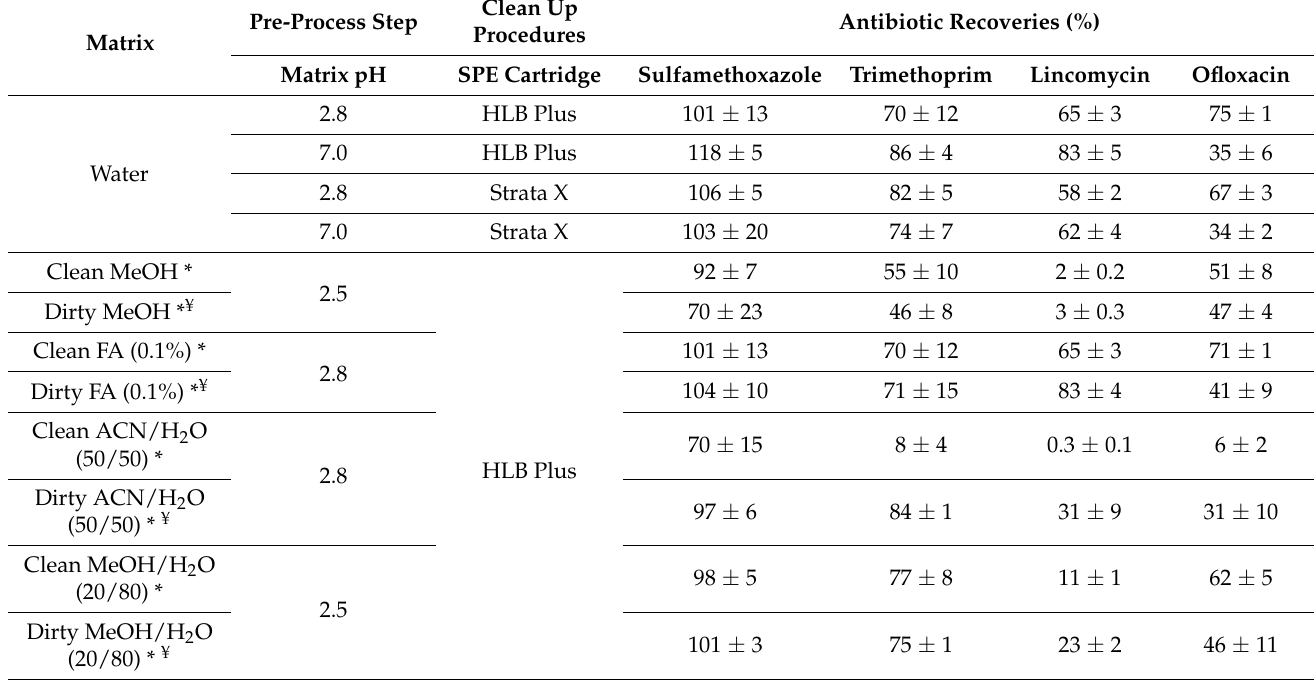
Table 3. Average percent recoveries ( ± standard deviation) of four antibiotics extracted from water and clean versus dirty extracting * solutions using different pre-processing steps and cleanup